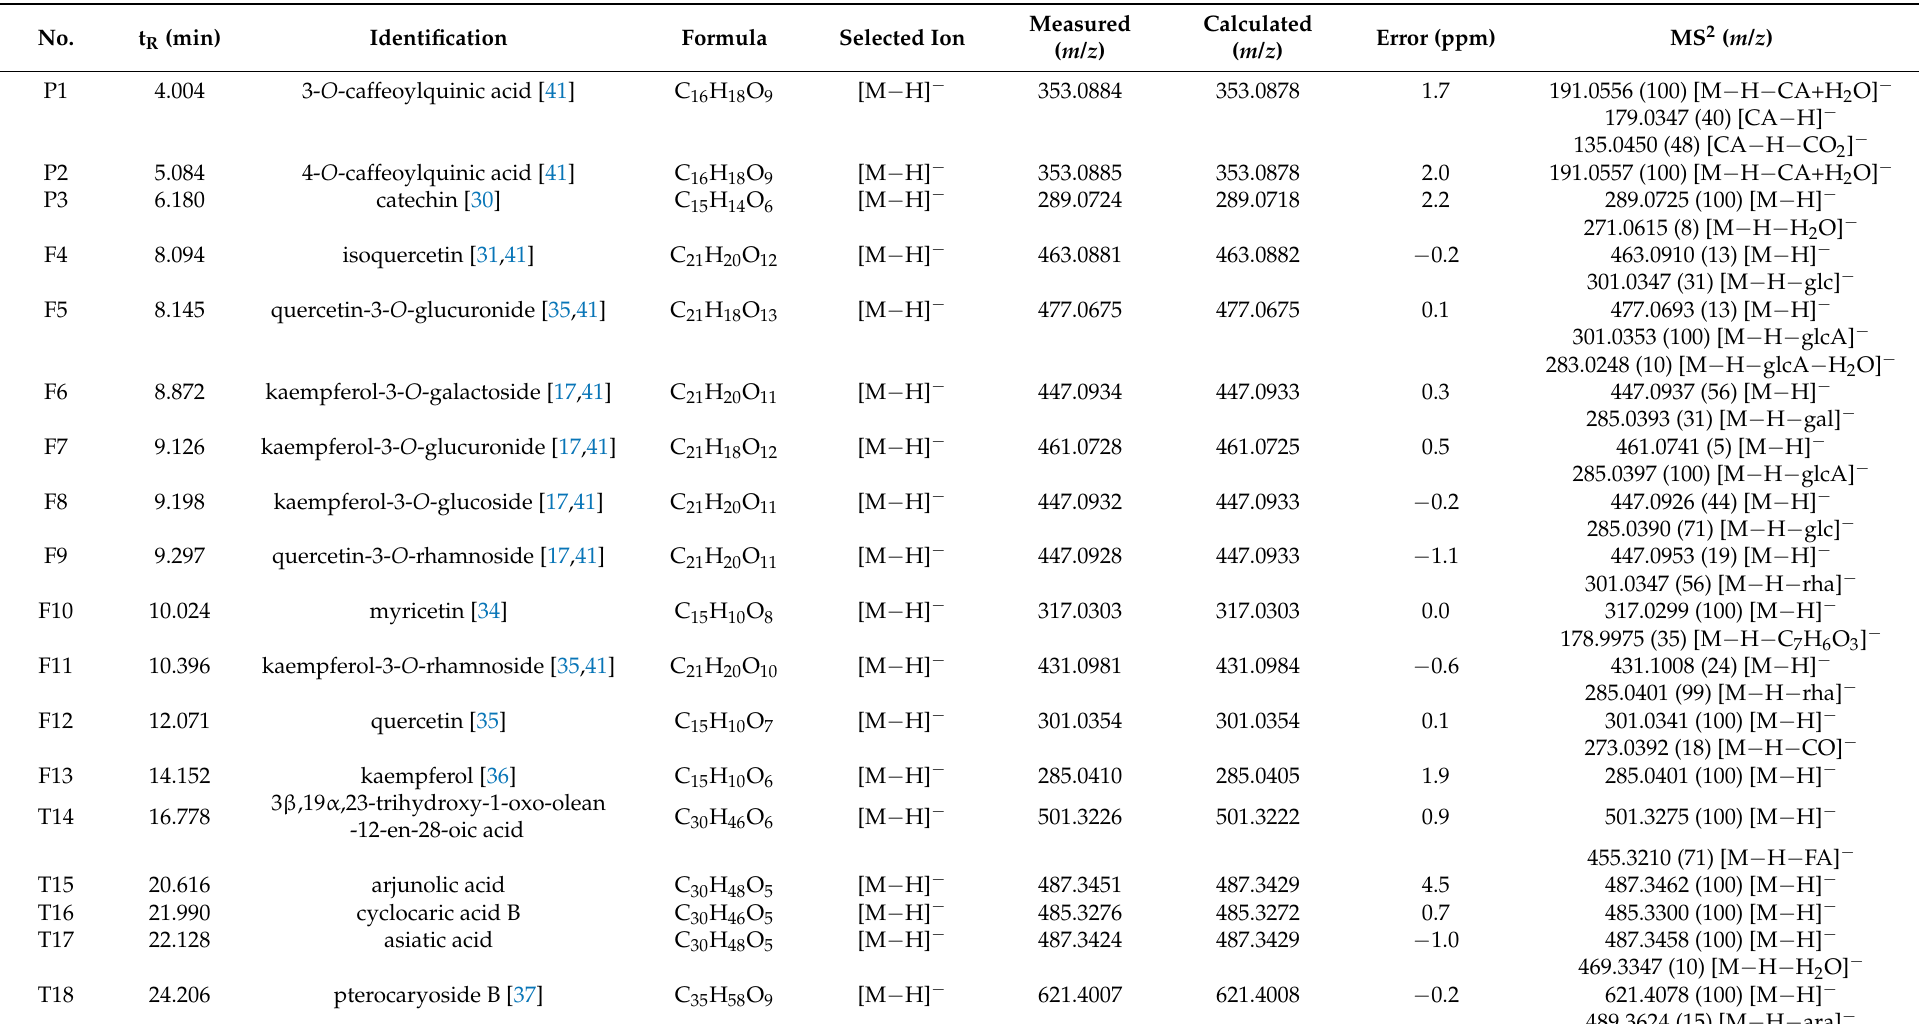
Table 1. Identification of the chemical constituents in CPE by